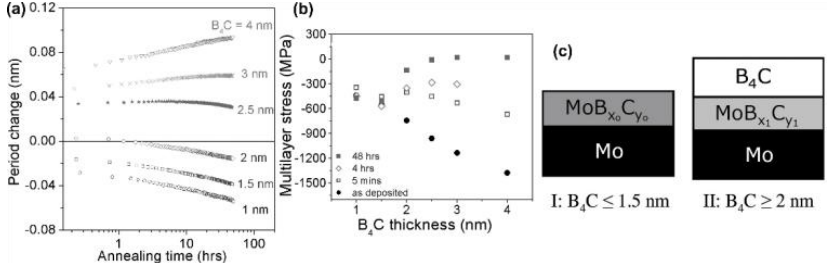
Figure 11. ( a ) Change in the thickness period to the annealing time at 300 °C in the Mo/B 4 C PMMs. ( b ) The stress in the Mo/B 4 C PMMs to the B 4 C thickness at the as-deposited state and different annealing times. ( c ) Schematic depiction of the structural differences in as-deposited Mo/B 4 C PMMs with thicknesses. It is shown that, before thermal treatment, the PMMs with B 4 C ≤ 1.5 nm would possess no or very little pure B 4 C, whereas the PMMs with B 4 C ≥ 2 nm would still possess pure B 4 C. Reprinted from [29] with the permission of AIP Publishing. In place of Mo, Zhu et al. [34] used Mo x C 1-x to grow 100 bilayer Mo x C 1-x /B 4 C PMMs on Si substrate to compare the effect of stress and thermal treatment. After repeated thermal treatment from 100 to 600 °C, the Mo/B 4 C multilayers showed a ∼ 2% decrease in reflec- tivity near-normal incident, whereas Mo x C 1-x /B 4 C multilayers proved to be more stable with a 1.4% decrease in reflectivity. However, the ⁓ 11% reflectivity value of the as-pre- pared Mo x C 1-x /B 4 C multilayers made it less competitive in the choice of optical perfor-